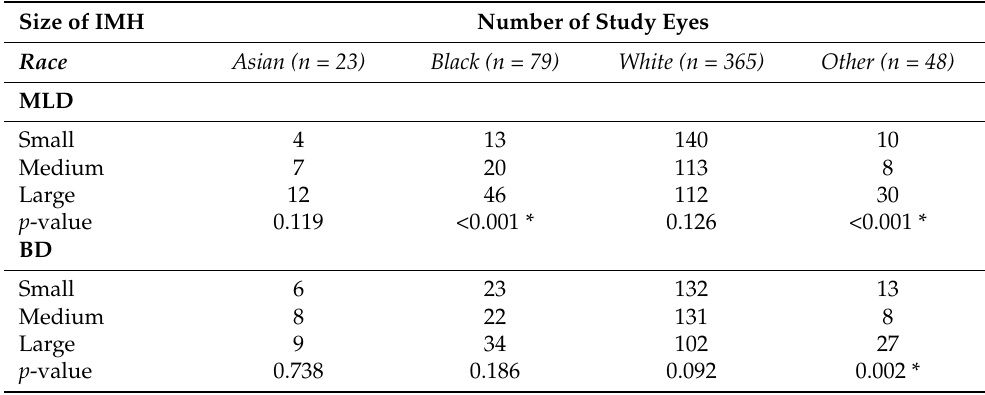
Table 6. Number of small, medium, and large IMH by MLD and BD categorized by race. Size of